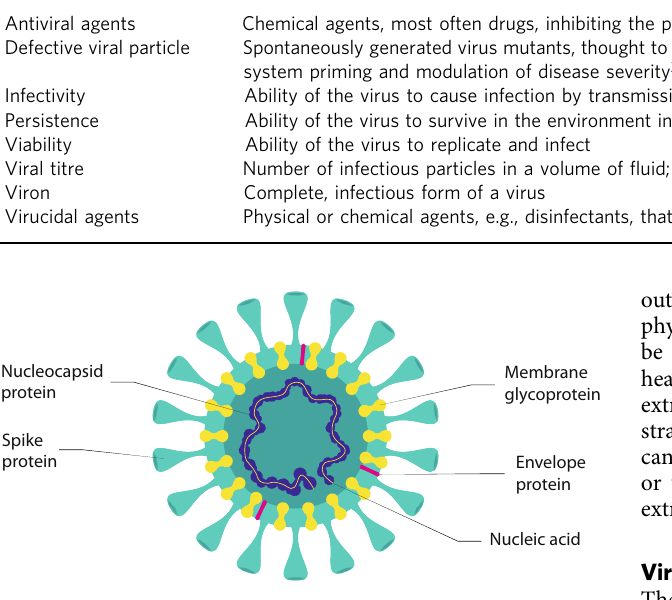
Fig. 1 Schematic of a virus structure based on coronavirus. The nucleic acid for replication is protected by a protein capsid which is contained within a protective envelope consisting of envelope proteins, glycoproteins and is decorated with a spike protein to bind to